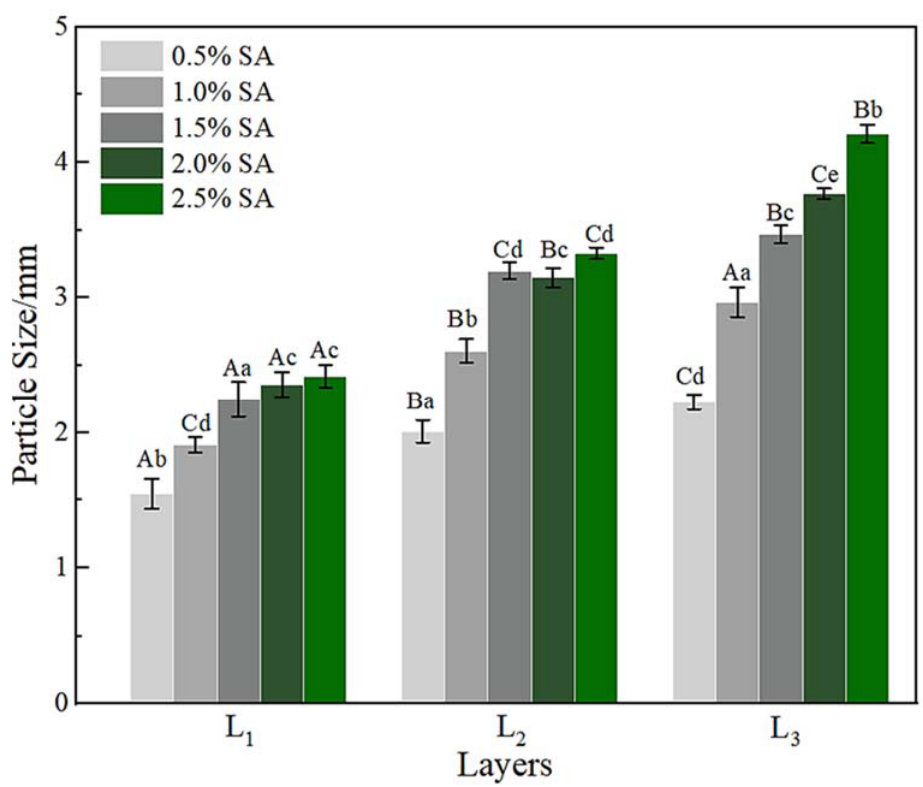
Figure 3. The particle size of L 1 , L 2 , and L 3 . L 1 : the one-layer-gel microspheres; L 2 : the two-layer-gel microspheres; L 3 : the three-layer-gel microspheres. Different lowercase letters indicate significant differences ( p < 0.05) of the particle size within the same number of layers. Different capital letters indicate significant differences ( p < 0.05) of the particle size between different number of layers.